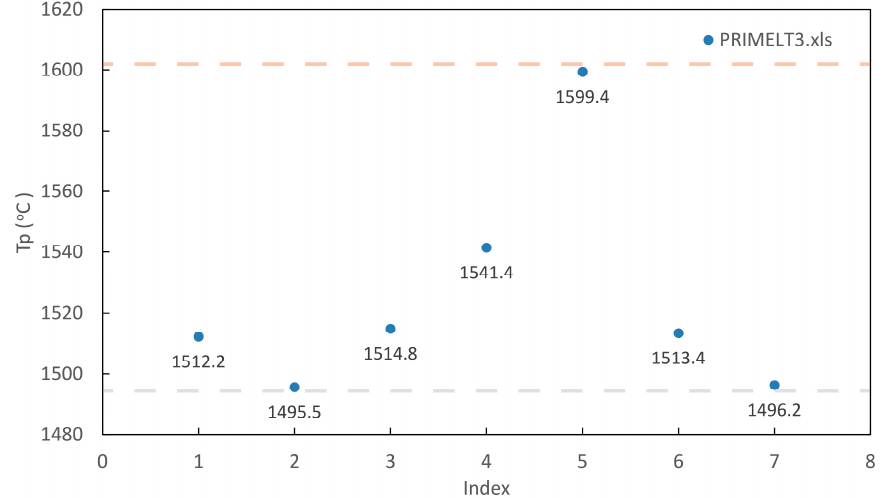
Figure 4. The Tp is calculated with the software PRIMELT3 [42]. The grey and orange dotted lines indicate the approximately minimum (1500 °C) and maximum (1600 °C) values, respectively. The horizontal axis corresponds to the “index” row in Table 1. Minerals 2018 , 8 , 73